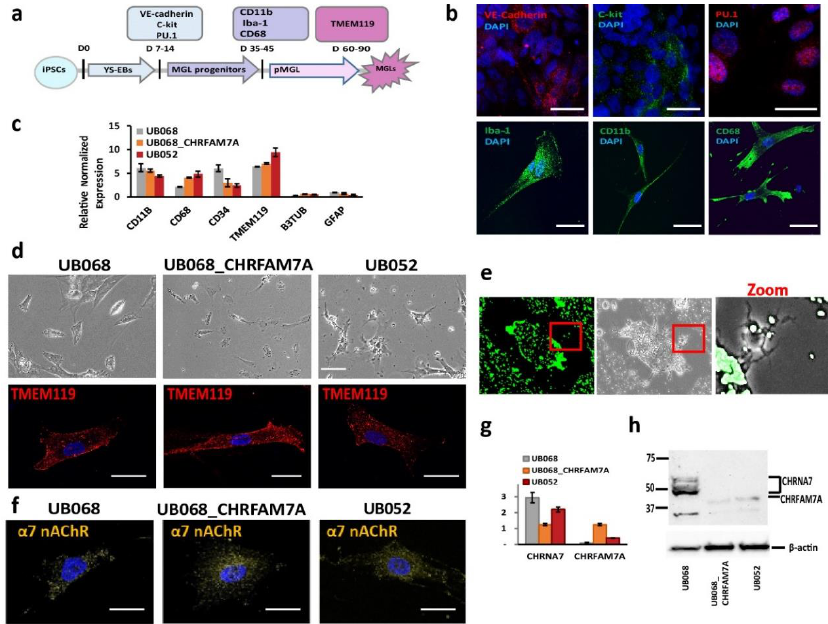
Figure 1. Characterization of microglia-like (MGL) cells derived from CHRFAM7A carrier and non-carrier induced pluripotent stem cell (iPSC) lines: ( a ) Schematic timeline depicts the stages of the MGL di ff erentiation from the iPSC lines and the stage-specific markers used for the characterization of MGL cells. ( b ) Representative confocal images of the yolk sac embryoid bodies (YS-EBs; D 14) plated on PDL-laminin (upper panel) and the MGL progenitors (D 30; lower panel). Scale bar, 20 µ m. ( c ) RT-qPCR demonstrates gene expression profiles of the MGL cells (D 60) di ff erentiated from the CHRFAM7A carrier and non-carrier iPSC lines ( n = 5; three independent cultures). ( d ) Live (phase-contrast microscopy, upper panel; scale bar, 100 µ m) and stained MGL cells with microglia marker TMEM119 (lower panel; scale bar, 20 µ m). ( e ) Representative images depict the intracellular accumulation of phagocytosed fluorescent beads and the cleared area around the MGL cells (t = 24 h; scale bar, 100 µ m). Higher magnification of the area in the red frame is shown on the right. ( f ) Confocal images demonstrate the surface expression of α 7 nAChR in MGL cells derived from the iPSC lines. Scale bar, 20 µ m. ( g ) RT-qPCR indicates that the presence of CHRFAM7A decreased the expression levels of CHRNA7 in CHRFAM7A carrier lines ( n = 5; three independent cultures). ( h ) Immunoblot (Millipore-Sigma, Cat# AV35409) demonstrated the expression of CHRNA7 and CHRFAM7A in MGL cells derived from the three iPSC lines. Note that CHRFAM7A was detected only in the UB068_CHRFAM7A and UB052 lines ( n = 5; three independent